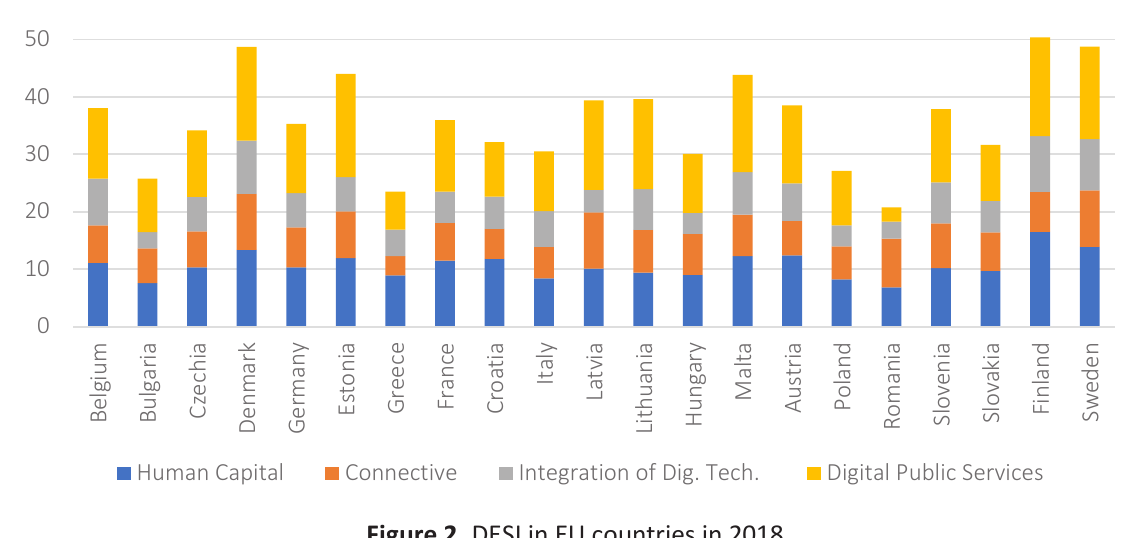
Figure 2. DESI in EU countries in 2018